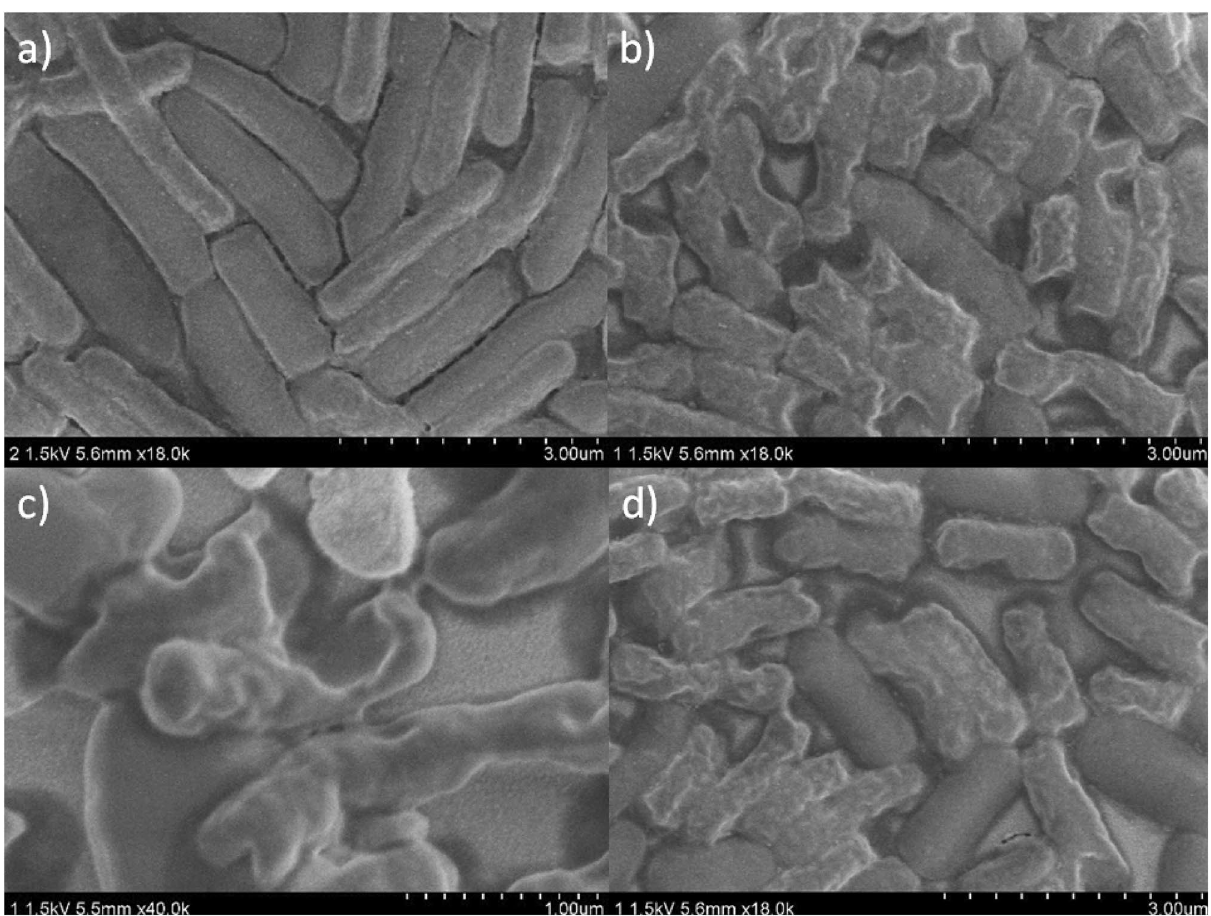
Figure 3. SEM images of ( a ) untreated E. coli and E. coli with disrupted cell walls after treatment with ( b , c ) GCN/Ag (bacteria on image ( c ) were captured at higher magnification), ( d ) GCN/Ag and